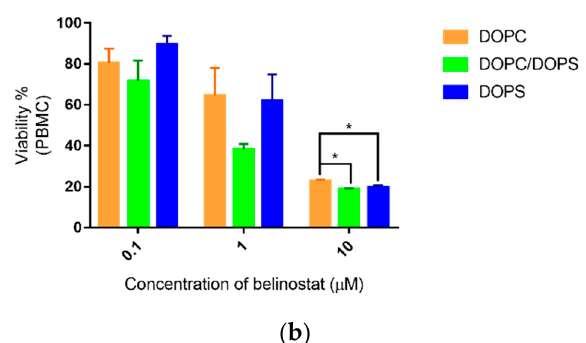
Figure 7. The safety assessment of liposomal formulations. ( a ) In vitro hemolysis of erythrocytes induced by liposomal formulations and observation. The positive control was RBCs dissolved in water and the negative control was RBCs dissolved in PBS (pH 7.4). ( b ) In vitro cytotoxicity of PBMCs. Notes: Data are shown as mean ± SD ( n = 3). * p < 0.05compared to control group. Table 4. In vivo toxicity assessment of complete blood count and liver function assays of belinostat free drug and loaded liposome system in balbc mice after subcutaneous administration in balb/c mice at 0.333 mg/g dosage.